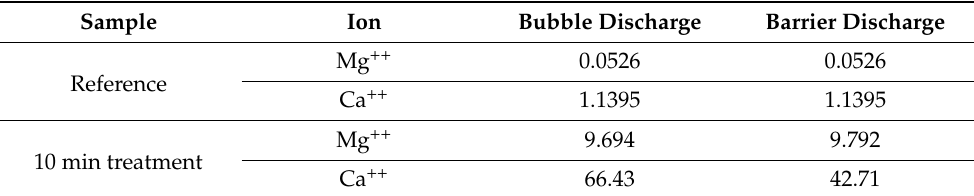
Table 2. The concentration (mg/L) of calcium and magnesium ions in ground water before and after plasma